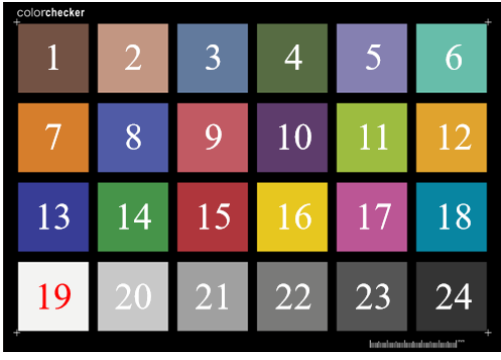
Figure 5. X-Rite Color Checker Chart. 292